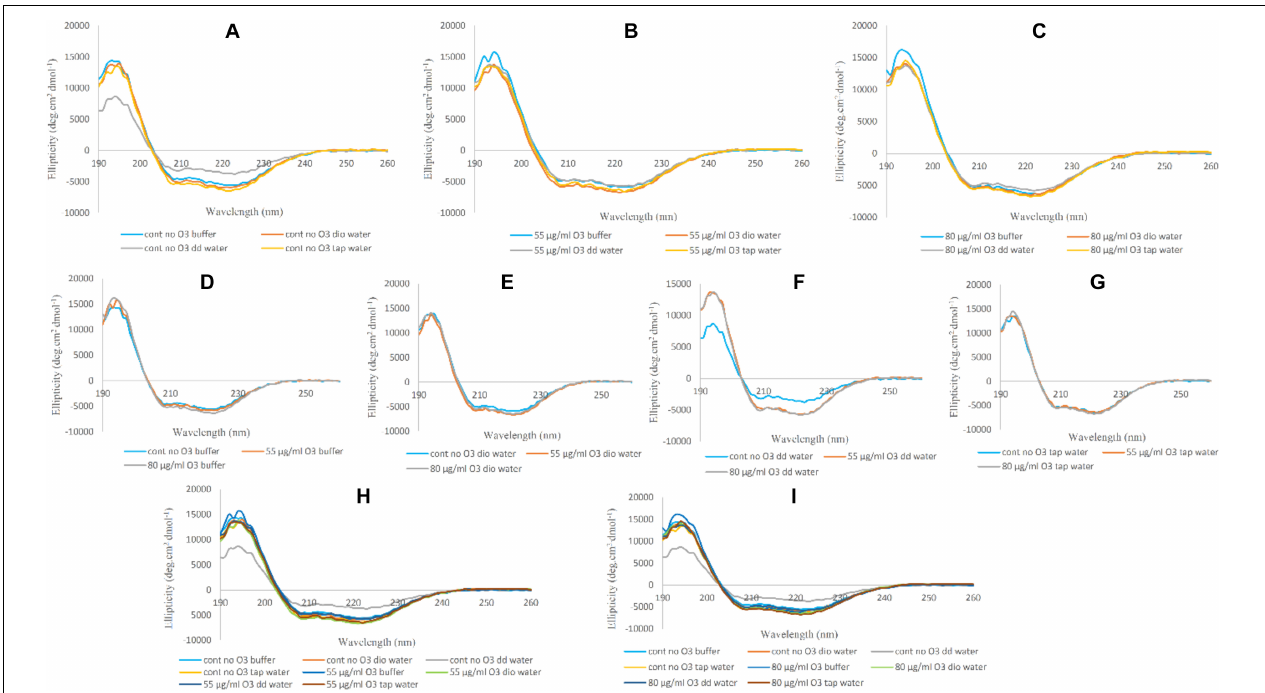
FIGURE 3 | Far-UV CD spectra of non-ozonated and ozonated Hb samples in the presence of phosphate buffer and diluted versions with different water types. (A) Non-ozonated Hb in phosphate buffer and different water types. (B) Hb ozonated with 55 µ g/ml ozone in phosphate buffer and different water types. (C) Hb ozonated with 80 µ g/ml ozone in phosphate buffer and different water types. (D) Non-ozonated and ozonated Hb with 55 and 80 µ g/ml ozone in phosphate buffer. (E) Non-ozonated and ozonated Hb with 55 and 80 µ g/ml ozone in phosphate buffer diluted with deionized (Dio) Water. (F) Non-ozonated and ozonated Hb with 55 and 80 µ g/ml ozone in phosphate buffer diluted with double distilled (DD) Water. (G) Non-ozonated and ozonated Hb with 55 and 80 µ g/ml ozone in phosphate buffer diluted with Tap Water. (H) Non-ozonated and ozonated Hb with 55 µ g/ml ozone in phosphate buffer and diluted in various different water types. (I) Non-ozonated and ozonated Hb with 80 µ g/ml ozone in phosphate buffer and diluted in various different water